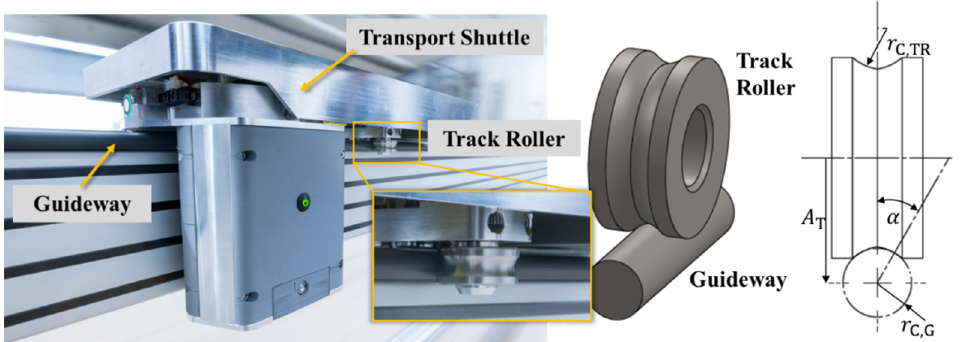
Figure 1. Use of a locating bearing track roller in a monorail transport system; Photo: HA Hessen Agentur GmbH—Jan Michael Hosan. Table 1. Parameter and values of the selected example.